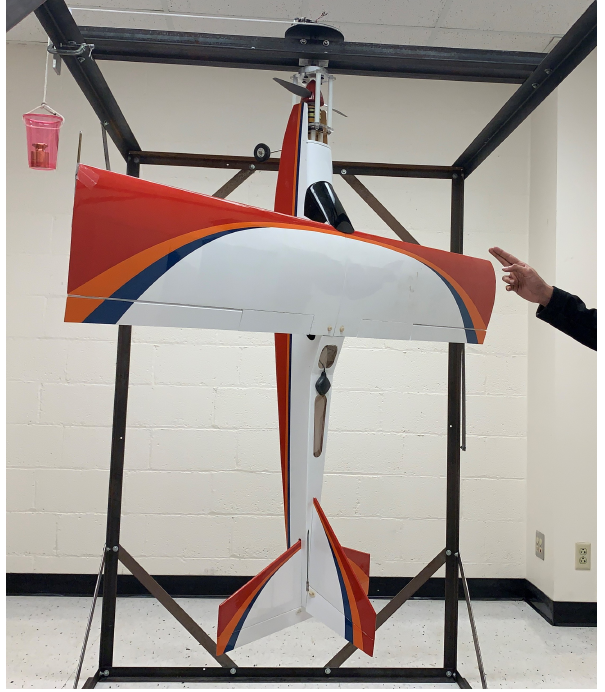
Figure 9. Roll moment of inertia testing of the flight-ready Avistar UAV